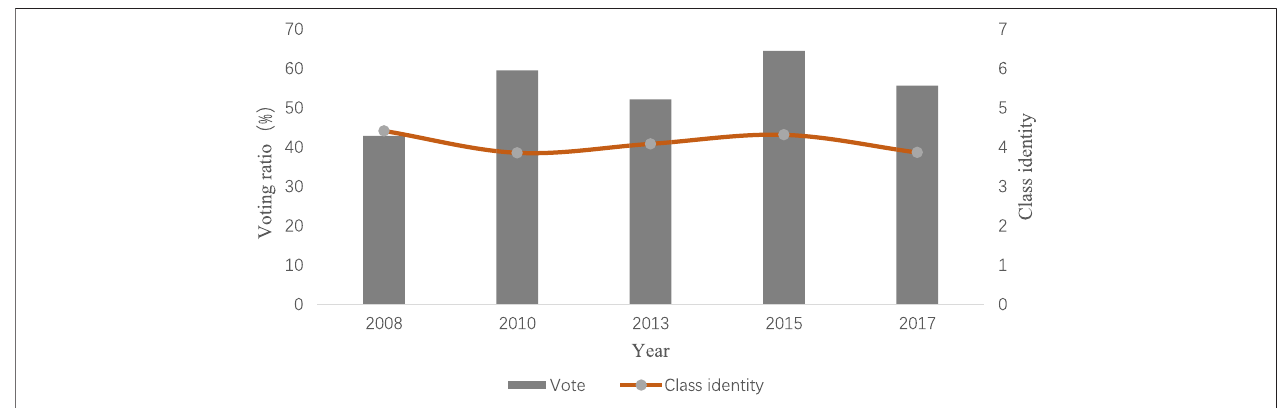
FIGURE 1 | Trend chart of class identity and voting ratio in villagers ’ committee election (data source: China General Social Survey 2008 – 2017).